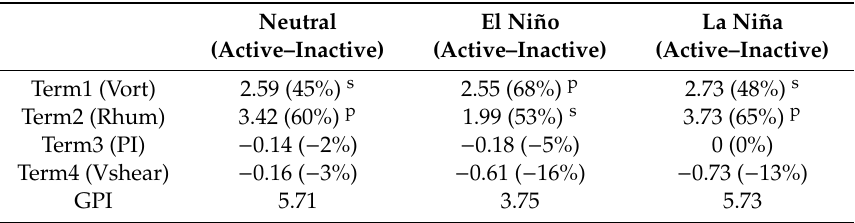
Table 2. Relative contributions to the genesis potential index (GPI) anomaly changes between the active and inactive MJO phases of absolute vorticity (Vort), relative humidity (Rhum), potential intensity (PI), and wind shear (Vshear) over the SCS for di ff erent ENSO conditions during June–November over the period of 1979–2016.